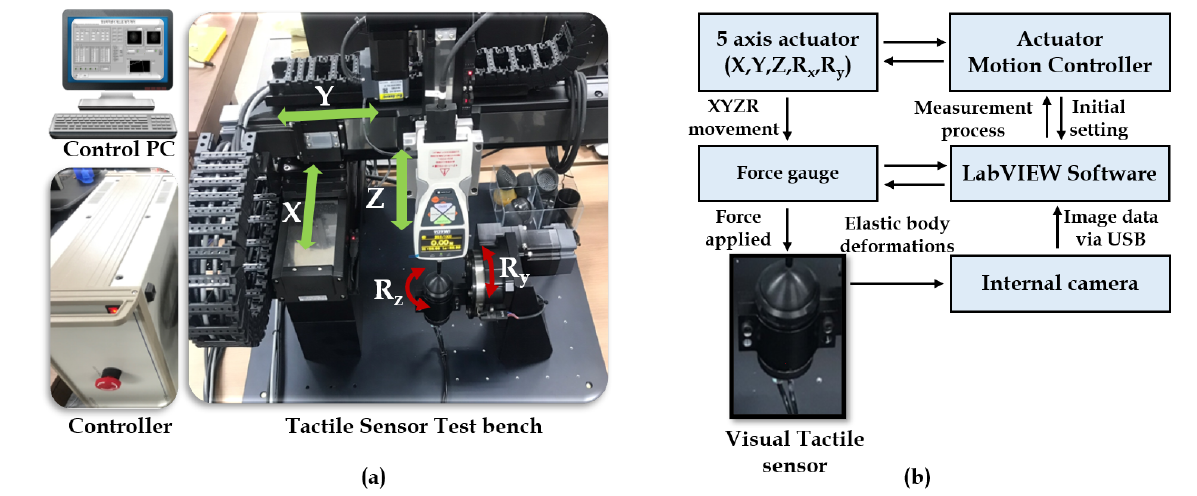
Figure 3. Equipment setup and schematic: ( a ) Overall system installation. ( b ) Flow schematic of visual tactile sensor